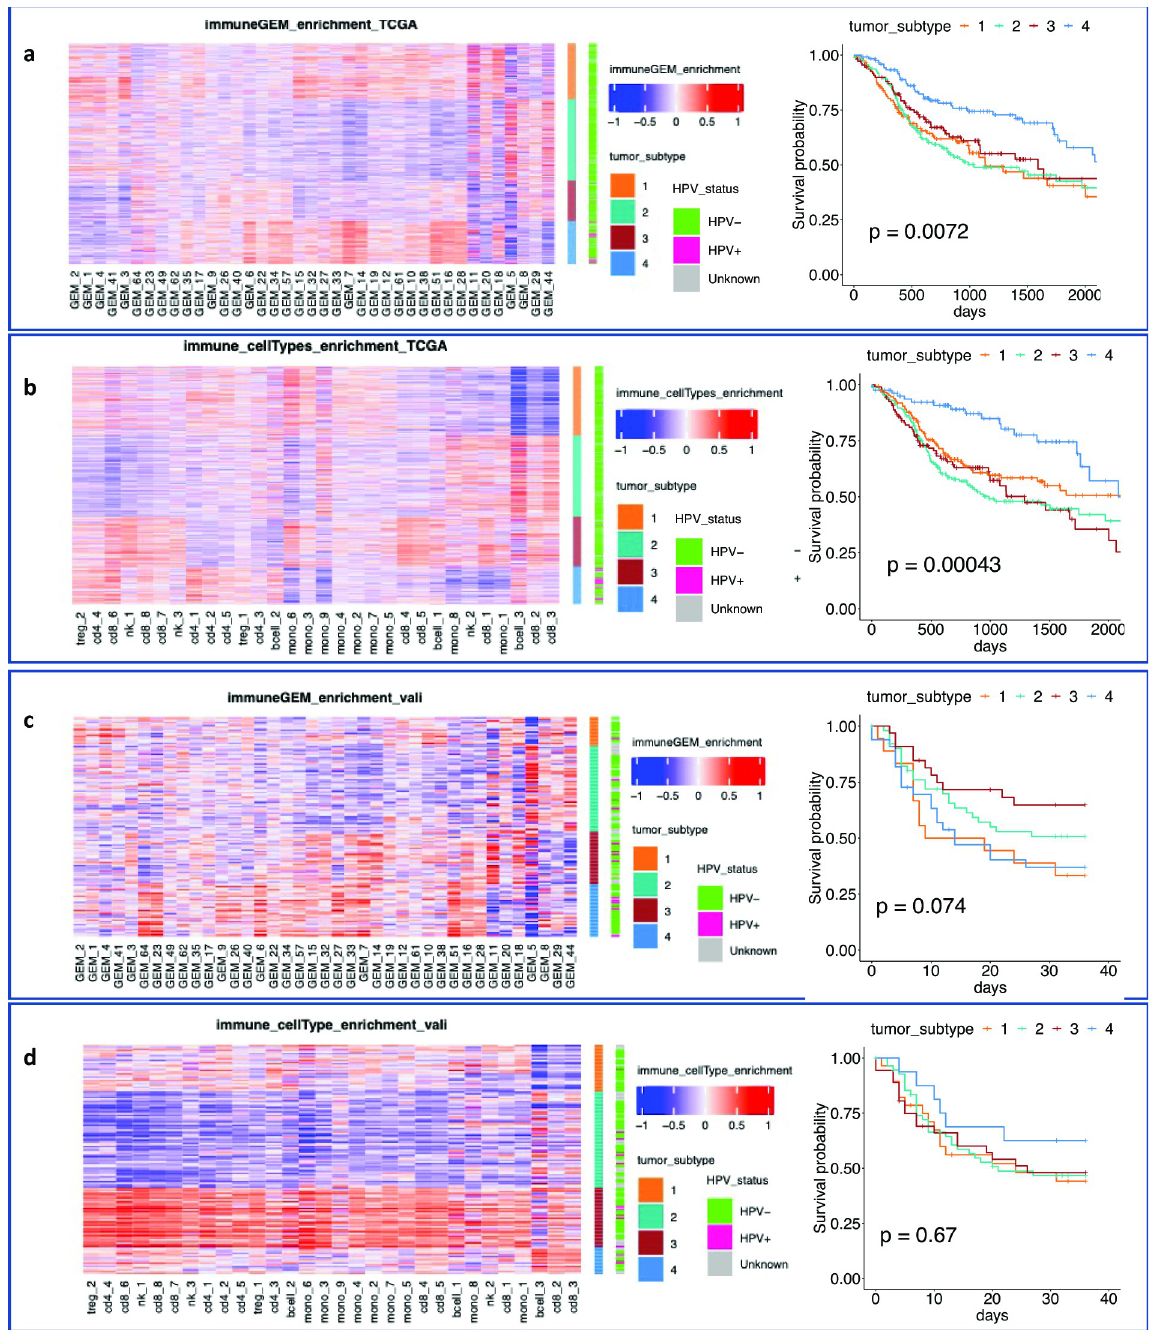
Fig 3. Distinct immune environment of HNSCCs defined by GEMs and cell subtypes. a. Heatmap reflecting relative expression levels of GEMs (columns) among TCGA tumors (rows). Tumors are organized according to the clustering results, with color bars that indicate the tumor subtype cluster id. Kaplan-Meier curves of patients belonging to different clusters are shown on the right, using the same color scheme ids. b. Heatmap reflecting relative enrichment of immune cell subtypes among TCGA HNSCC tumors. Tumors are organized according to clustering results, and Kaplan-Meier curves of patients belonging to different clusters are shown on the right. c. Immune GEMs (with id indicated by the number) that are associated with statistically significant hazard ratios. d. Immune cell subtypes (indicated by major cell type, followed by subtype cluster id) that are associated with statistically significant hazard